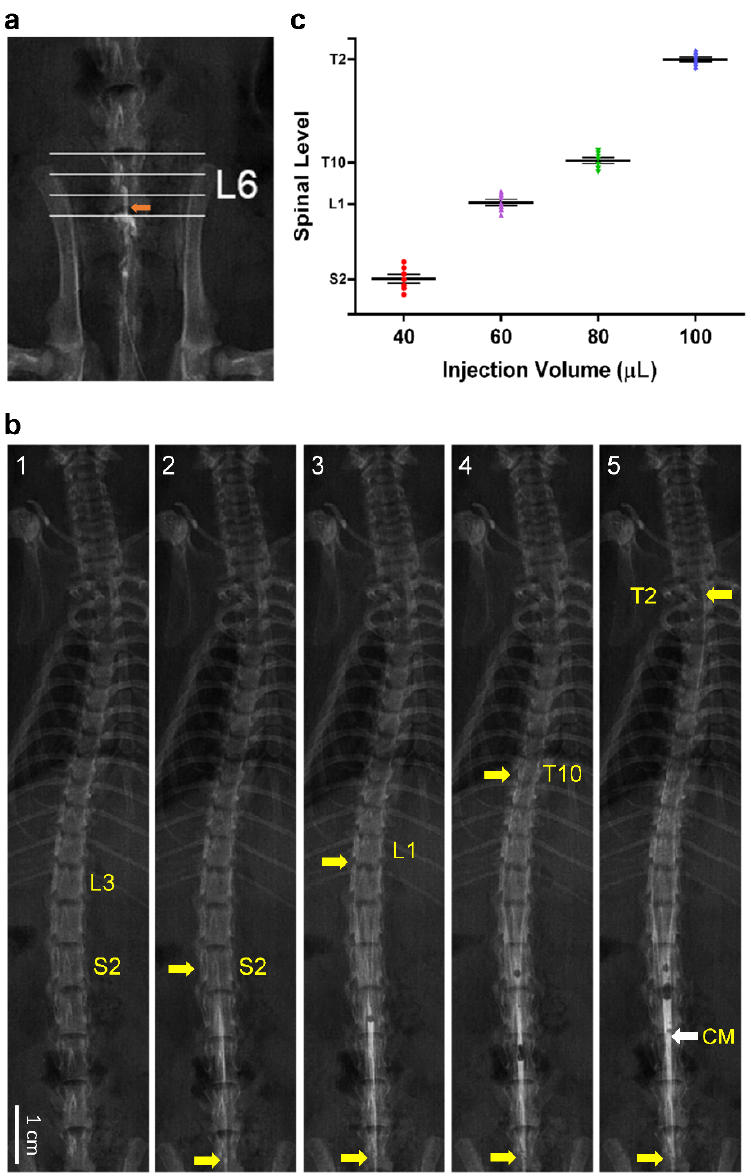
Figure 2. ( a ) Demonstration of lodging of the tip of the catheter (orange arrow) in the subarach- noid space below the middle portion of L6 vertebra. ( b ) Representative examples of myelographic examination before (1) and after intrathecal administration of four successive doses of contrast medium, given at 40 (2), 60 (3), 80 (4) or 100 (5) μL. Note that all demarcations denote levels of the spinal cord: the lower yellow arrows mark the location of the tip of the catheter, and the upper yellow arrows indicate the highest points reached by the enhanced roentgenological images. CM: conus medullaris. ( c ) Scattered plots showing the extent of dispersion in the spinal cord of contrast medium on intrathecal administration at 40, 60, 80 or 100 μL. Values are mean ± SEM of seven animals.